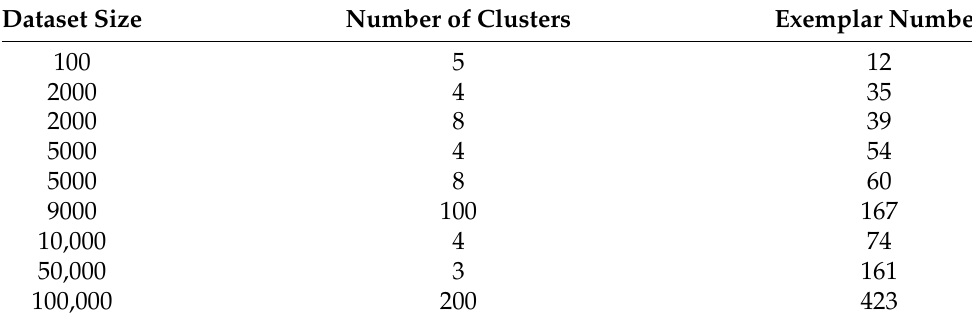
Table 2. Examples of exemplar numbers calculated for different scenarios. Dataset